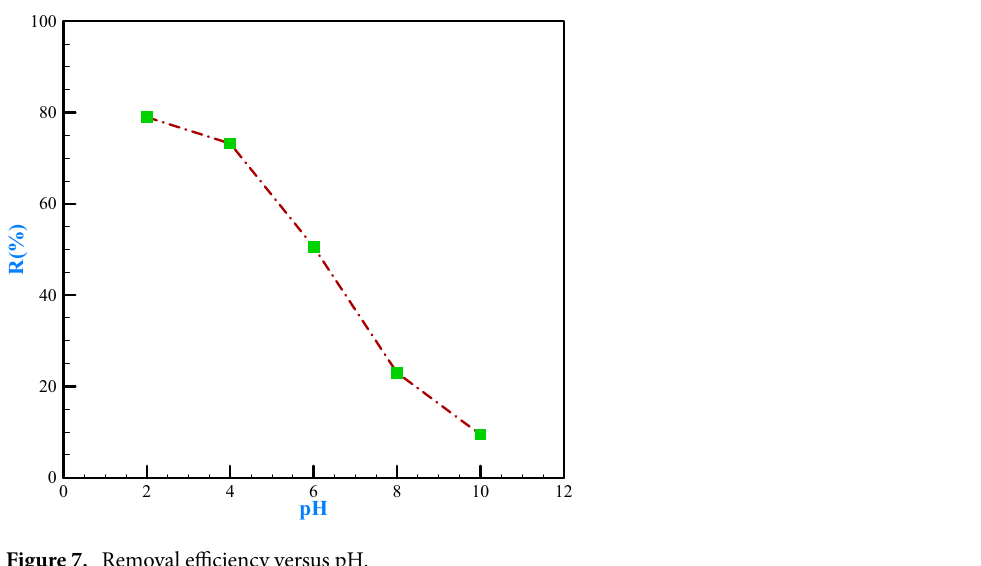
Figure 6. XRD pattern related to bee carcasses/polyaniline/polyethylene glycol composite.